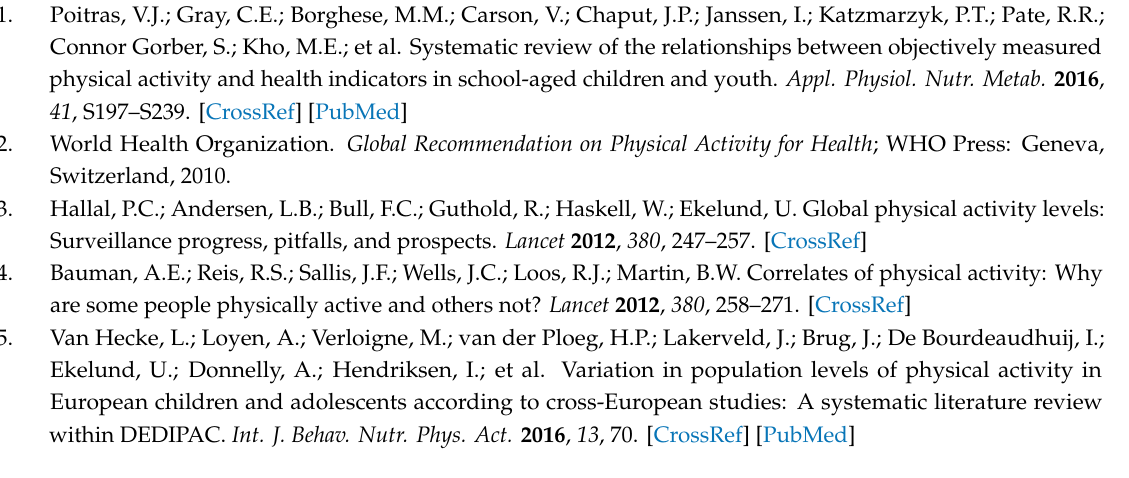
Figure S1: Network interactions among authors from the revised